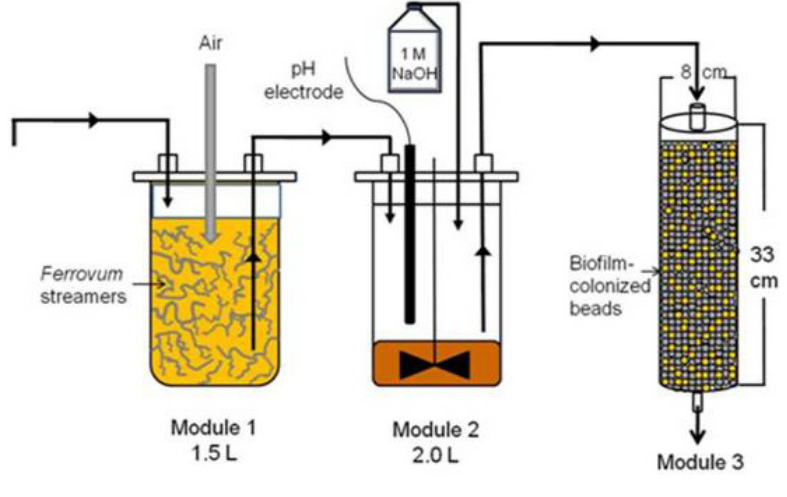
Figure 4. Schematic representation of a modular system described for precipitating iron present in waters draining metal mines as schwertmannite